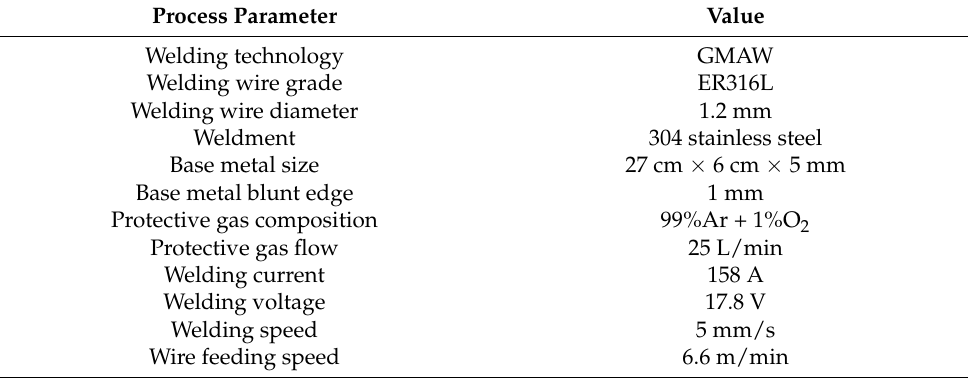
Table 1. Welding process parameters.